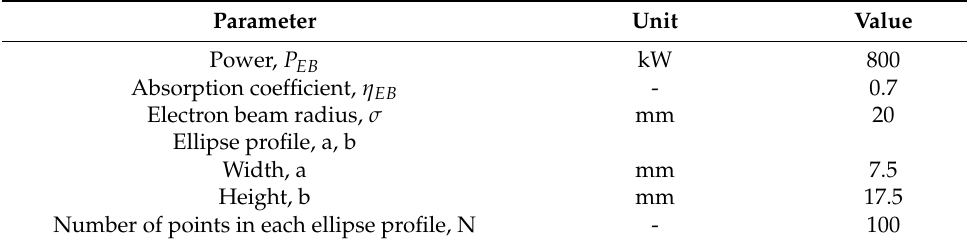
Table 2. Summary of electron beam scanning